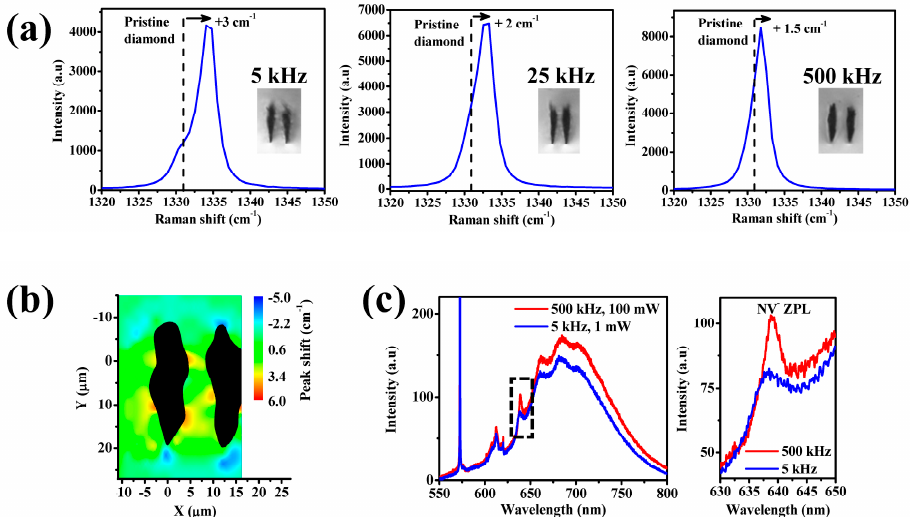
Figure 2. Effect of the repetition rate on the stress and the photoluminescence (PL) of the nitrogen-vacancy (NV) centers for double-line waveguides. ( a ) Shift of the Raman diamond peak at the center of the waveguide for different repetition rates. ( b ) Map of the shift of the Raman peak in a waveguide fabricated with 5 kHz. The laser modification tracks, where the amorphous carbon phase is formed, are shown as black. ( c ) PL of the NVs recorded at the center of waveguides fabricated with 500 kHz and 5 kHz repetition rates. The inset shows a zoomed in view of the spectra near the zero phonon line (ZPL) transition.